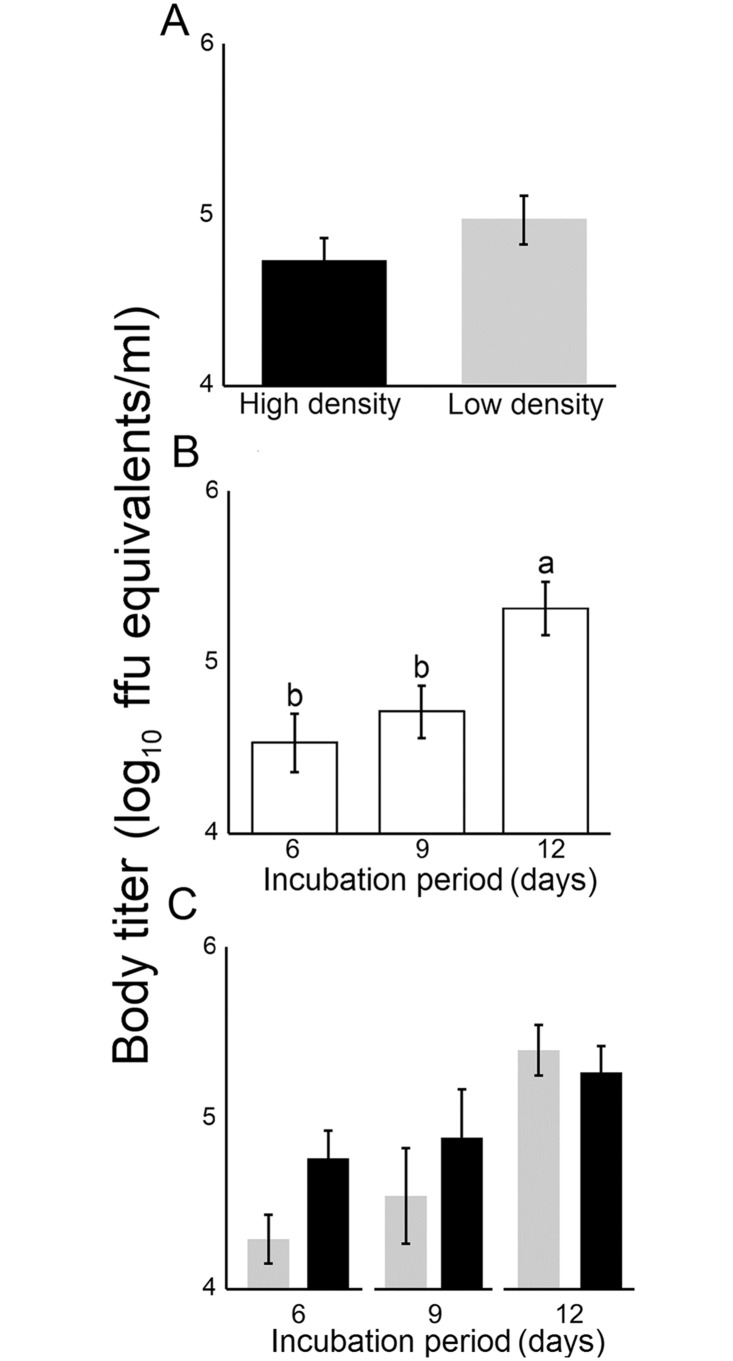
Effect of larval density (A), incubation period (B) and larval density by incubation period (C) on DENV titer in infected mosquito bodies.Bars above and below the means represent the standard errors of the mean. For each panel, estimates with a different letter are significantly different at P = 0.05, after controlling for multiple comparisons using the Tukey-Kramer adjustment.